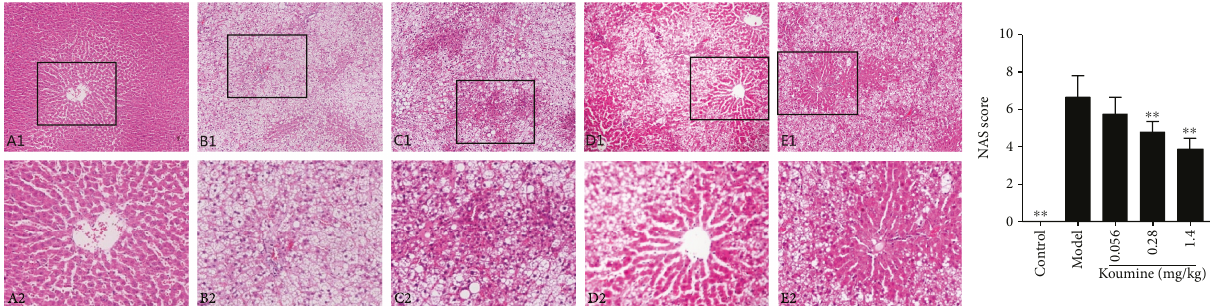
Figure 3: E ff ect of koumine on the pathomorphology of liver tissue induced by fat diet in NAFLD rats. A1-E1 represent the control group, model group, 0.056mg/kg koumine-treated group, 0.28mg/kg koumine-treated group, and 1.4mg/kg koumine-treated group, respectively ( × 100 magni fi cation); A2-E2 represent the same group with × 200 magni fi cation. ∗∗ p < 0 01 compared with the model